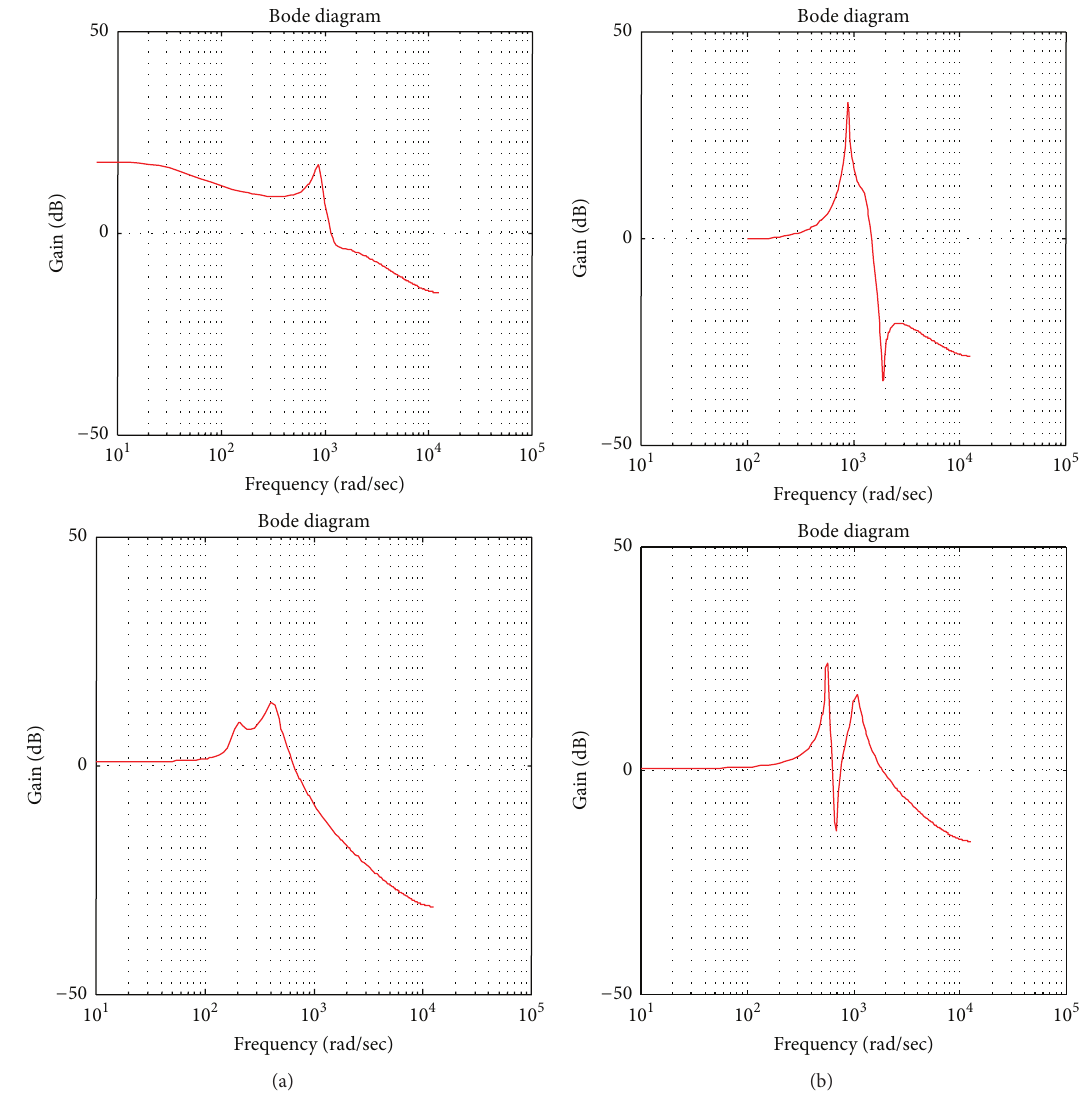
Figure 10: Bode plots for the fixture D at sections 1 and 4 for 120rpm (a) and 240 rpm (b).